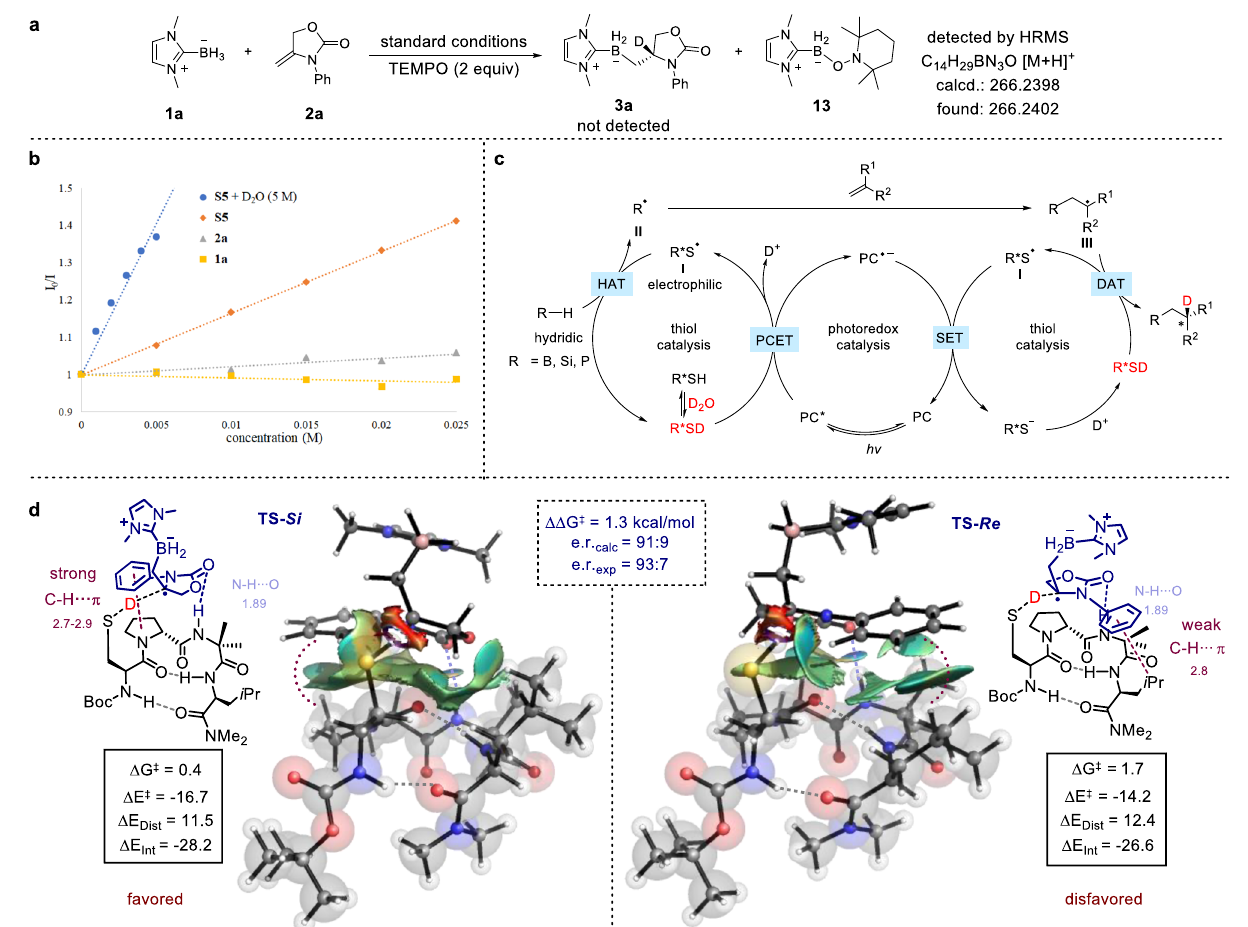
Fig. 5 | Experimental and computational studies of the mechanistic aspects of the reaction. a Radical trap experiment with TEMPO. b Stern − Volmer Plot. c Proposed catalytic cycle. d DFT calculated Re and Si transition states, including